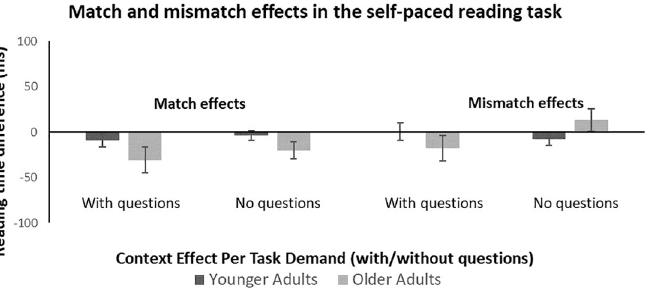
Fig 1. Match and mismatch effects in the self-paced reading task. Match (left) and mismatch effects (right) from the self-paced reading task. Match effects are computed as the difference in reading times between matched and neutral contexts, with negative scores showing a larger facilitation (faster reading during matched contexts). Mismatch effects are computed as the difference in reading times between neutral and mismatched contexts, with positive scores showing more hindrance (slower reading during mismatch contexts). Effects are shown for the part of the task with questions (left) and for the task just requiring reading for comprehension (no questions, right). Darker bars show results from younger adults and lighter bars from older adults. Error bars reflect +/- 1 standard error of the mean.